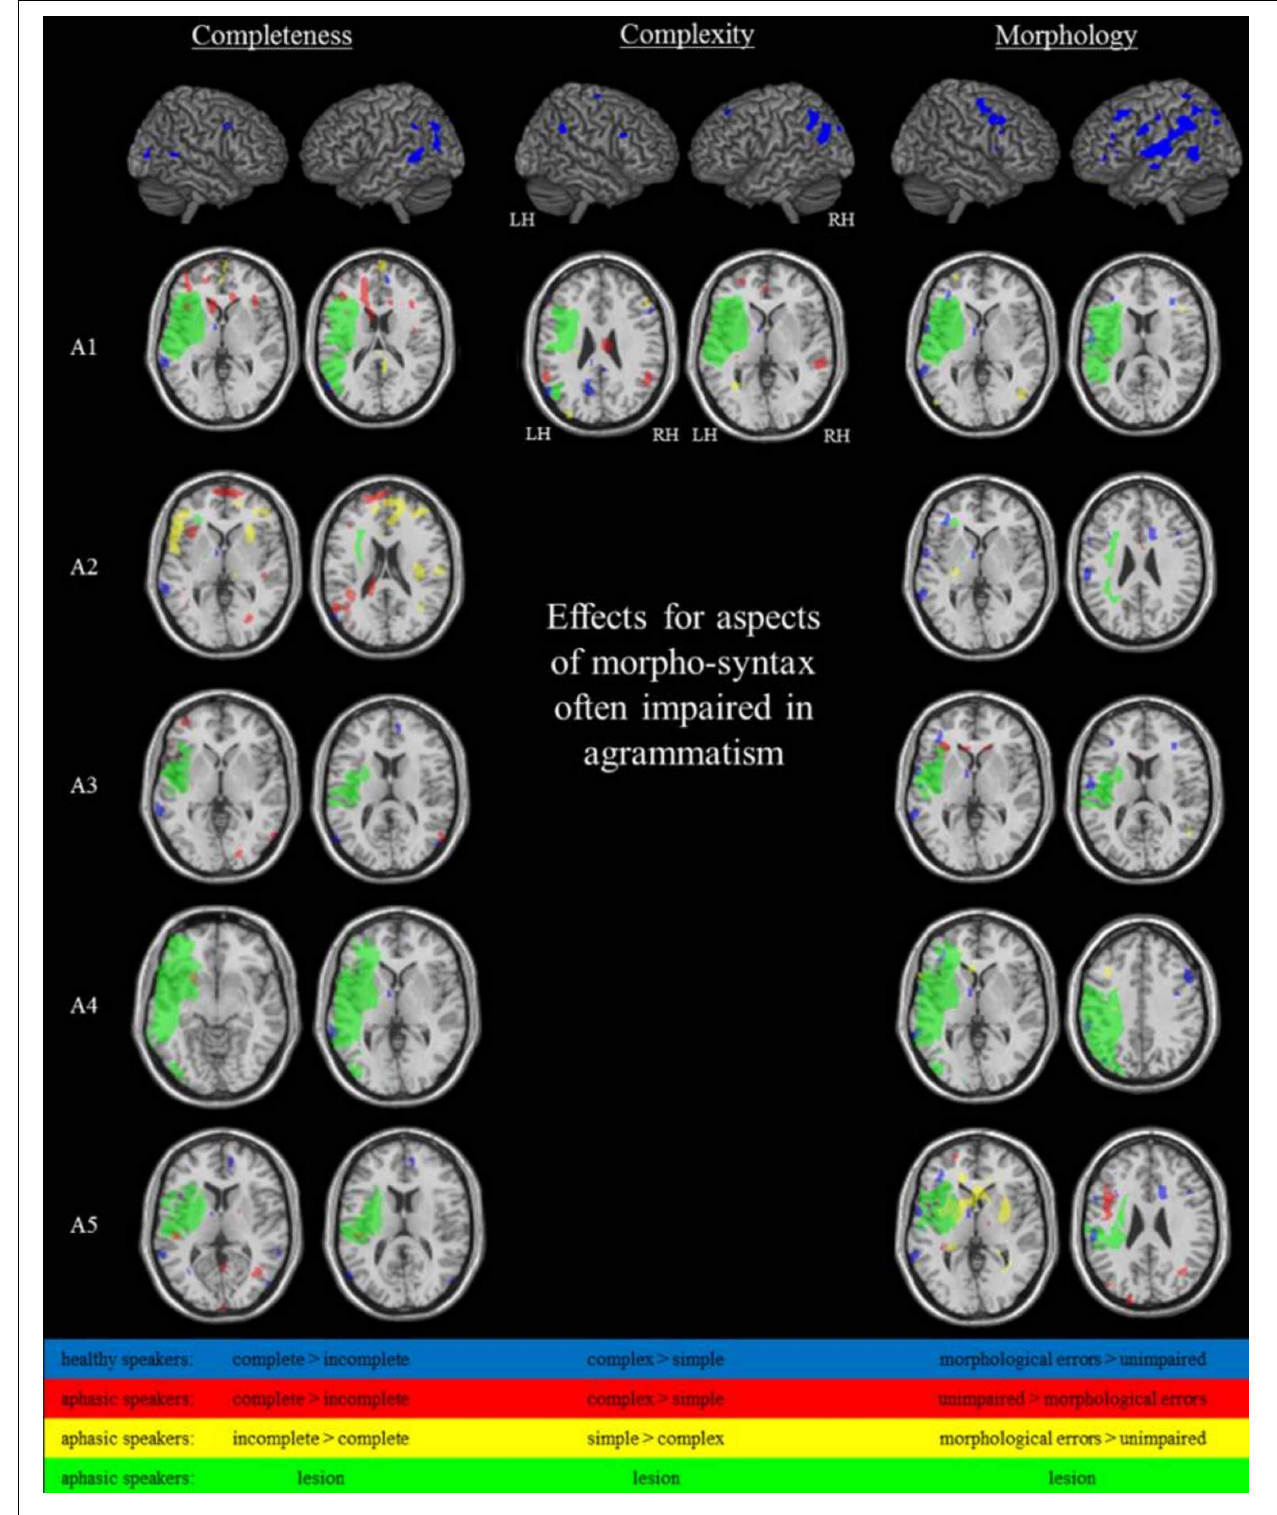
FIGURE 4 | Brain activation during the spontaneous language task at P < 0 . 001 uncorr , extend threshold k ≥ 14 voxels (healthy speakers) or P < 0 . 01 uncorr , extend threshold k ≥ 27 voxels (aphasic speakers/A1).